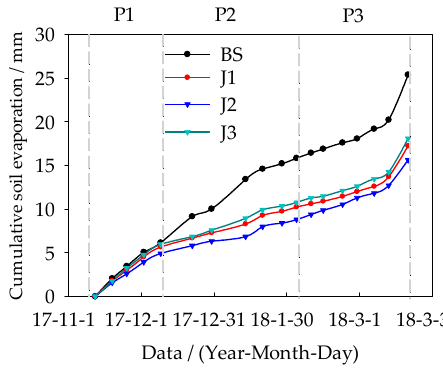
Figure 6. Cumulative soil evaporation during the freeze–thaw period.